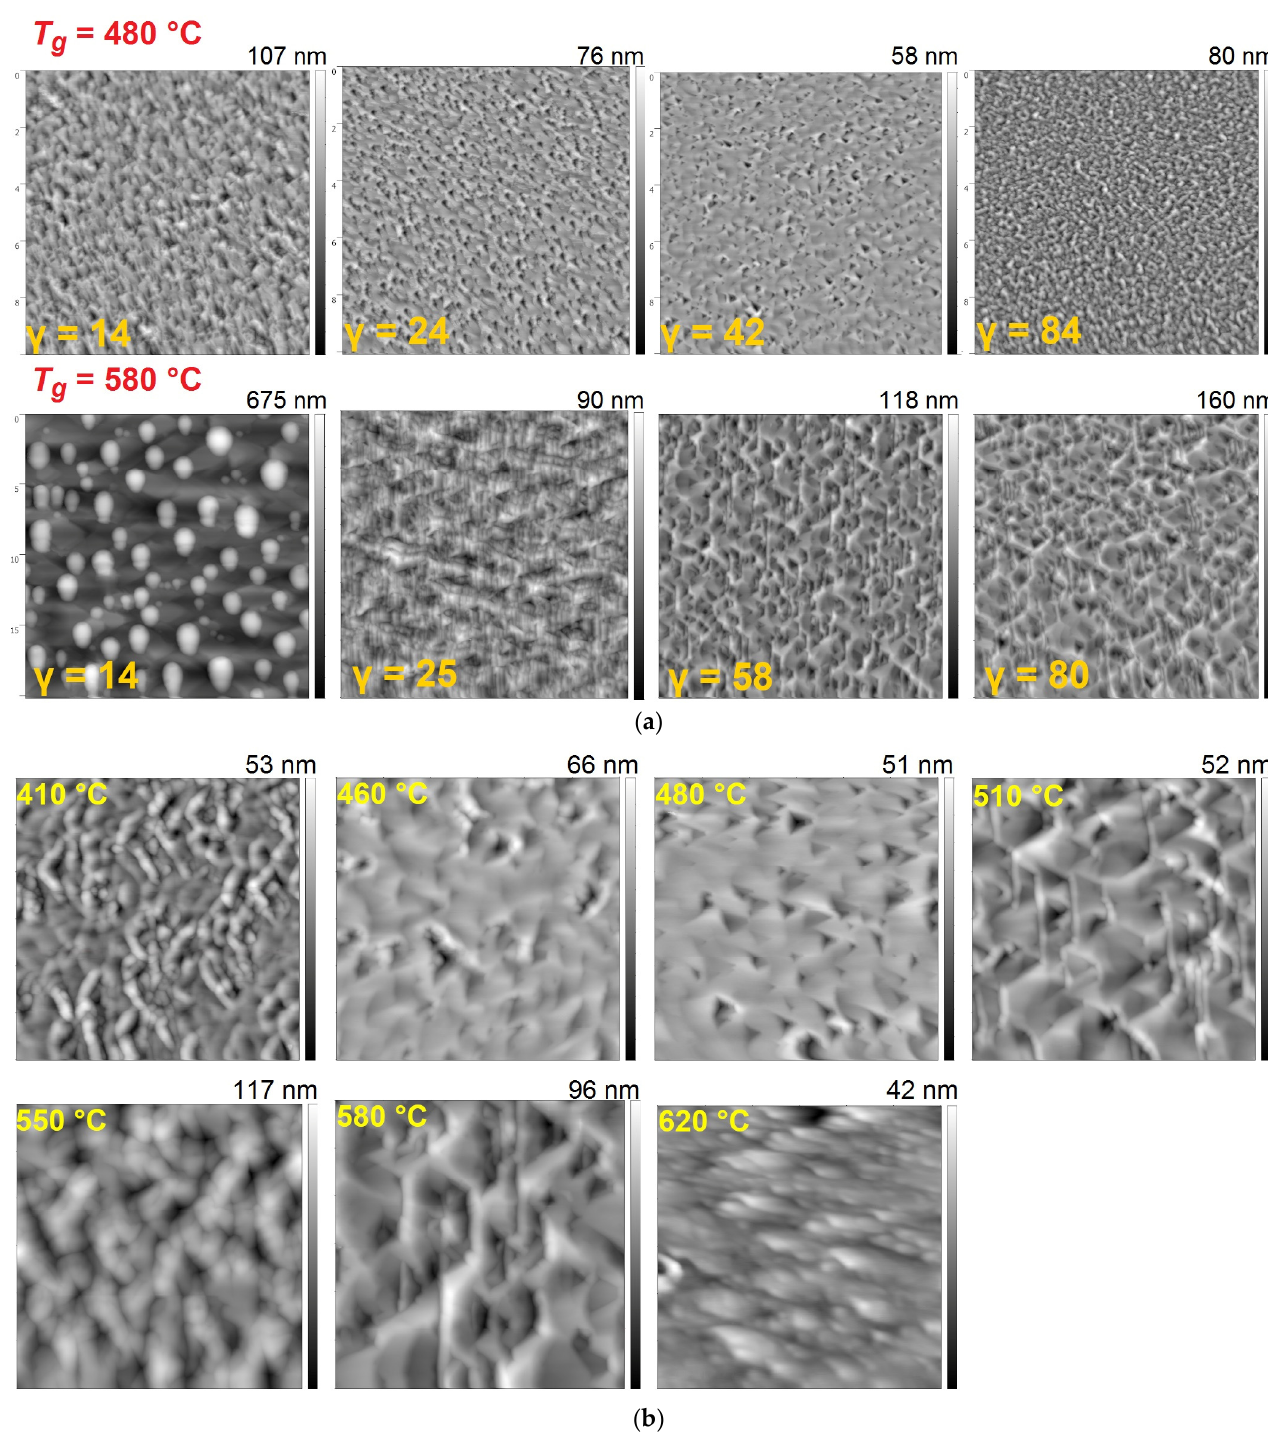
Figure 2. AFM surface maps of GaAs:Si (110) films: ( a ) 10 × 10 µ m 2 scans for films formed at T g = 480 and 580 °C with different As 4 fluxes; ( b ) 3 × 3 μ m 2 scans for films grown with different substrate temperature at γ = 40–60. The range of the color scale z is indicated above it.